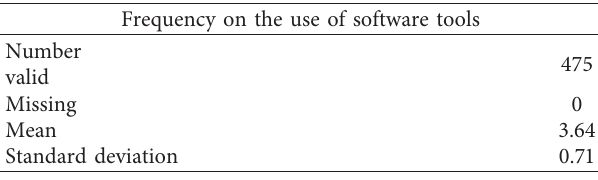
Table 5: Descriptive statistics on the frequency of use of software tools.